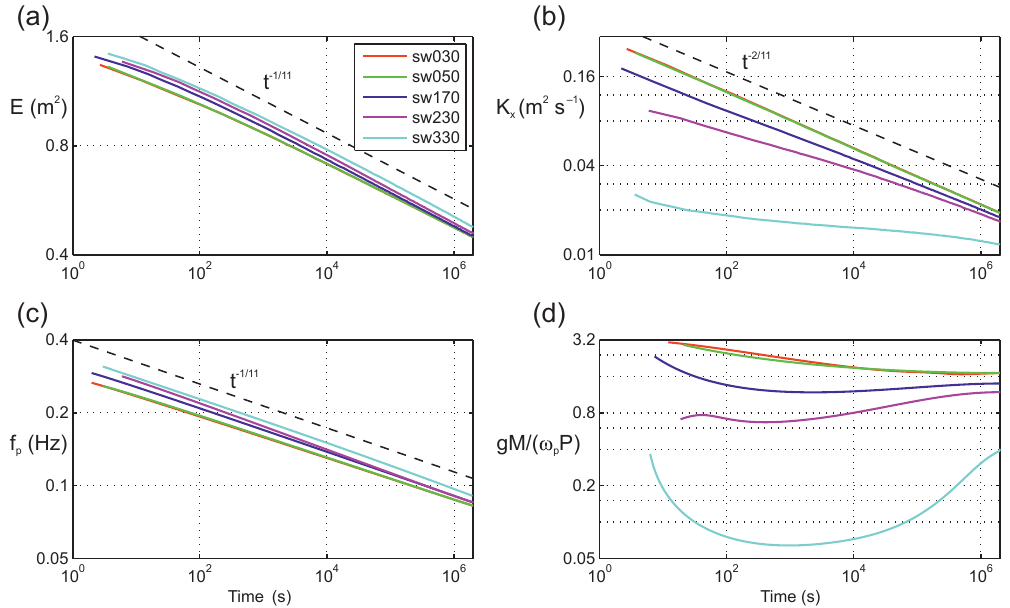
Figure 2. Evolution of wave parameters for runs of Table 1 (in the legend): (a) total energy E ; (b) total wave momentum K x ; (c) frequency f p = ω p /( 2 π) of the energy spectra peak; (d) estimate of the parameter of anisotropy A (Eq. 26). Dashed lines show asymptotic power laws (Eqs. 22 and 24)